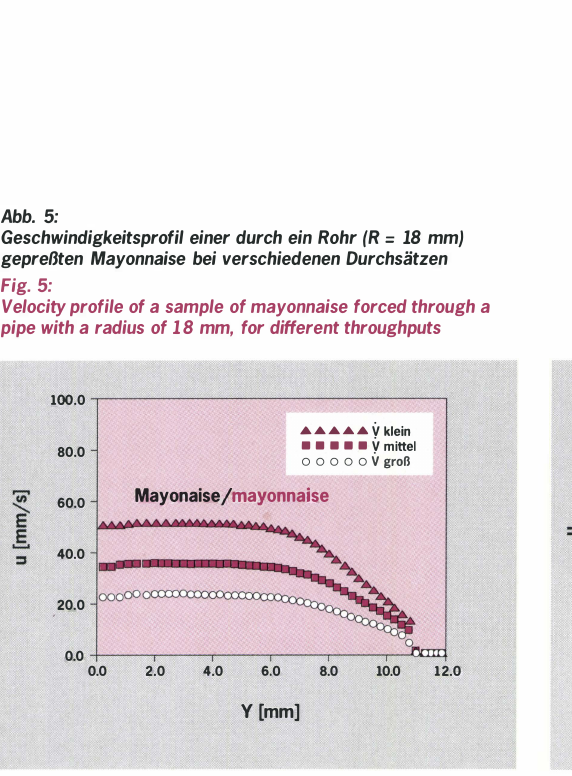
Fig. 5: Velocity profile of a sample of mayonnaise forced through a pipe with a radius of 18 mm, for different throughputs